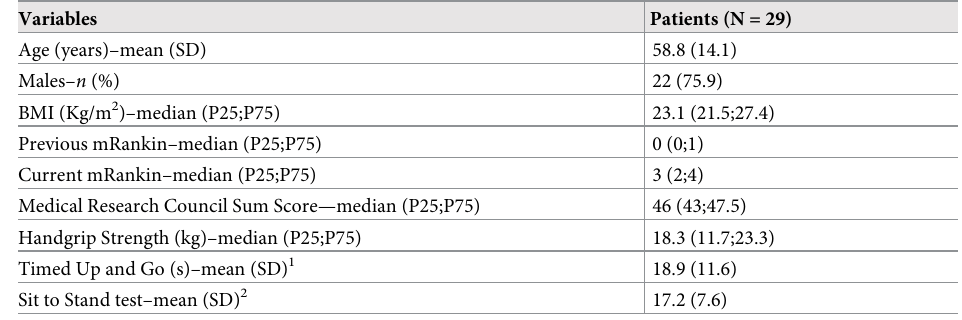
Table 1. Demographic characteristics of the sample and descriptions of functional